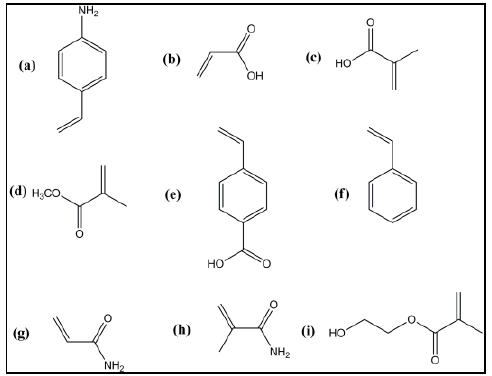
Figure 5. Chemical structures of common functional monomers used for MIP synthesis: ( a ) 4-vinyl aniline; ( b ) acrylic acid (AA); ( c ) methacrylic acid (MAA); ( d ) methyl methacrylate (MMA); ( e ) p -vinylbenzoic acid; ( f ) styrene; ( g ) acrylamide (AM); ( h ) methacrylamide; ( i ) 2-hydroxymethacrylate (HEMA).